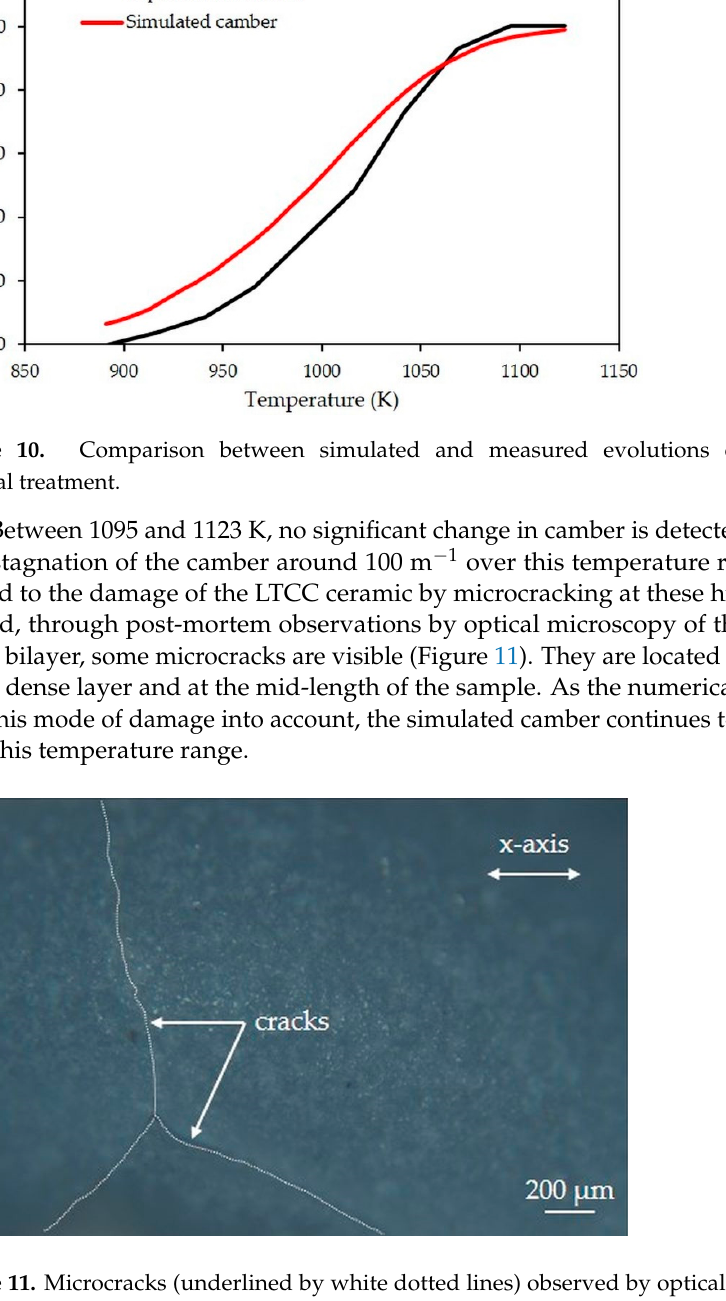
Figure 11. Microcracks (underlined by white dotted lines) observed by optical microscopy on the surface of the dense LTCC layer after heat treatment up to 1123 K. The indicated x -axis corresponds to the direction of sample length.